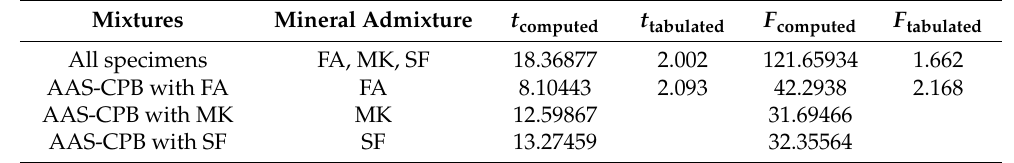
Figure 15. Links between UCS and UPV for AAS-CPB with ( a ) FA; ( b ) MK; ( c ) SF; and ( d ) all. To verify the implication of linear relations, t - and F -tests were performed (Table 4). A 95% level of confidence was chosen. The estimated t- and F-values were larger than the equivalent tabulated ones for all mixtures, indicating that all the models are valid. These findings indicate that the strength of AAS-CPB with mineral admixture can be predicted using a UPV test. Table 4. Results of the t - and F -test.